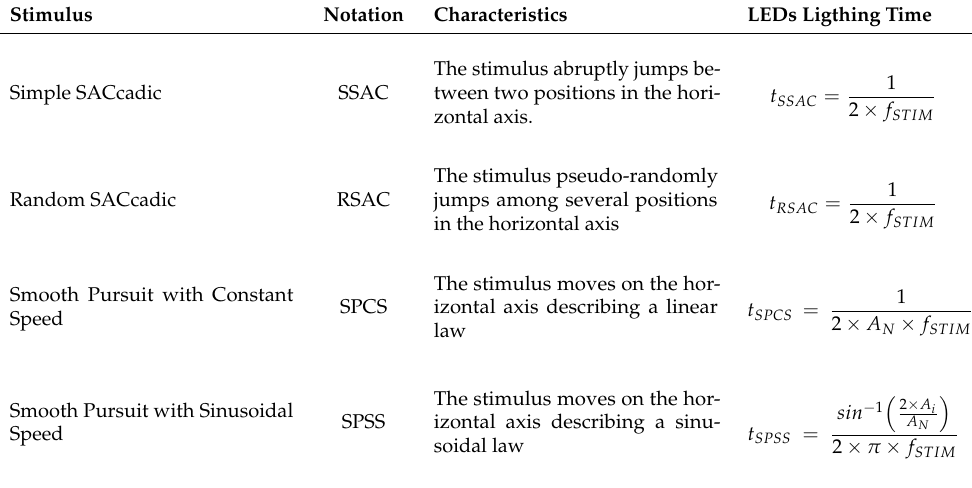
Table 1. Stimulus